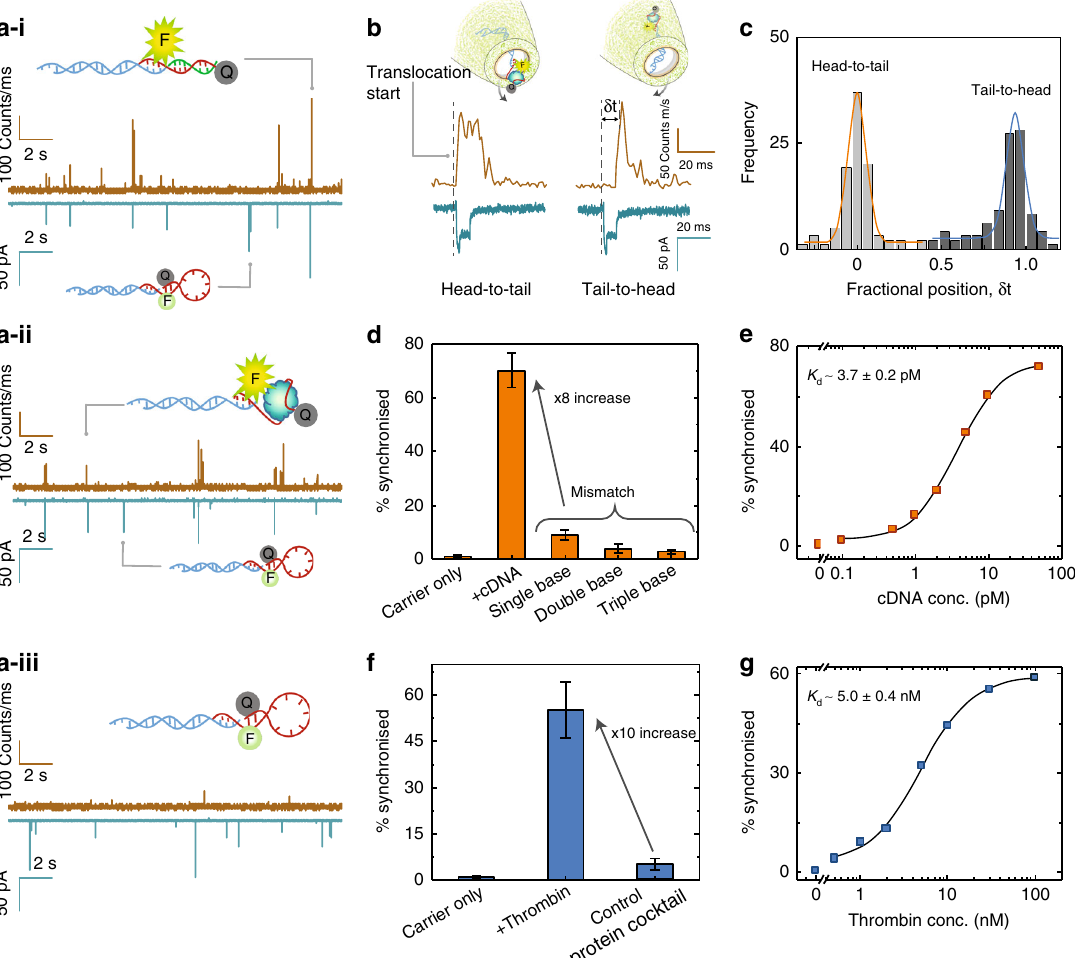
Fig. 4 Detection of DNA oligos and proteins using molecular beacons. Photon and current time traces are shown for the translocation of a-i DNA MB- Carrier-cDNA, a - ii DNA MB-Carrier-Thrombin, and a-iii DNA MB-Carrier. The DNA carrier, cDNA, and thrombin concentrations were 10 pM, 50 pM, and 30 nM respectively. Translocations were recorded at − 300 mV bias in a buffer of 100 mM KCl (pH = 8). b It was possible to determine the orientation of the complex translocating through the nanopore by characterising the c fractional position for the onset of the optical signal relative to the onset of the electrical signal ( N = 193). d Percent synchronisation between the optical and electrical channels for cDNA bound to the MB-Carrier along with controls including single, double and triple base mismatches. e A binding af fi nity of 3.7 pM was calculated by fi tting a Hill binding model for cDNA as a function of % synchronisation. f Percent synchronisation between the optical and electrical channels for thrombin bound to the MB-Carrier along with controls. g A binding af fi nity of 5.0 nM was calculated by fi tting a Hill binding model for thrombin as a function of % synchronisation which was in agreement with existing bulk methods. Error bars in f and h were determined using data obtained from a minimum of three different nanopipettes. In all cases, the